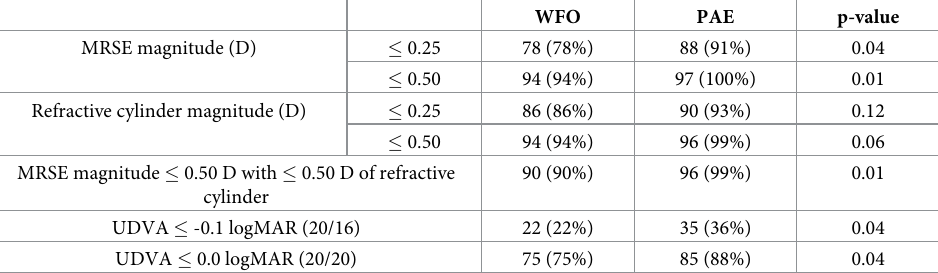
Table 3. Categorized postoperative refractive and visual acuity